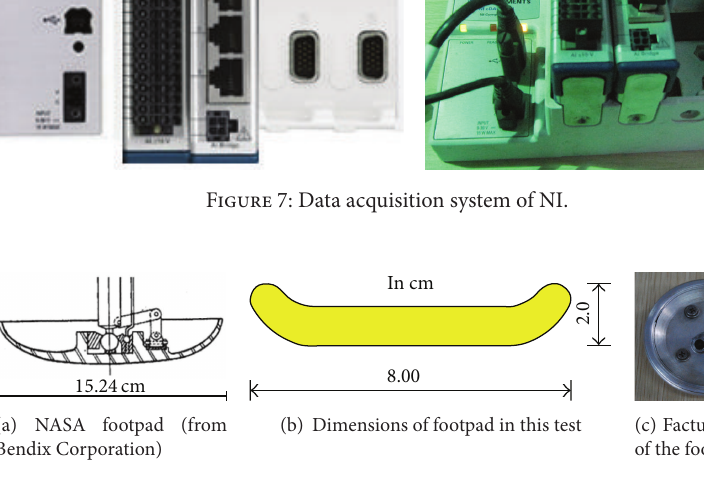
Figure 8: Experimental